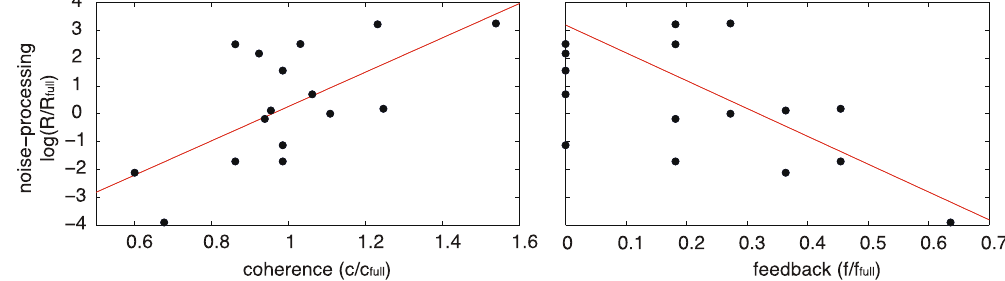
Figure 2. Plots of the data from Table 1. Removal of edges that result in an increase of coherence in the network tend to diminish the system’s noise-processing ability, while removal of edges which reduce the overall feedback structure of the network tend to improve the system’s noise-processing ability. Red lines show linear